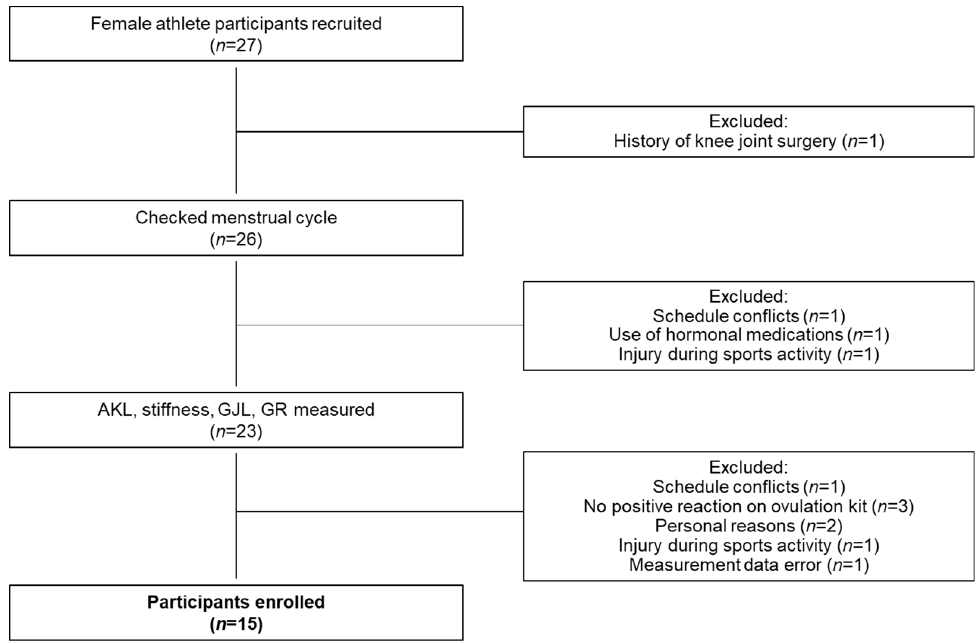
Figure 2. Flowchart for selection of female athlete participants. AKL, anterior knee laxity; GJL, gen- eral joint laxity; GR, genu recurvatum.